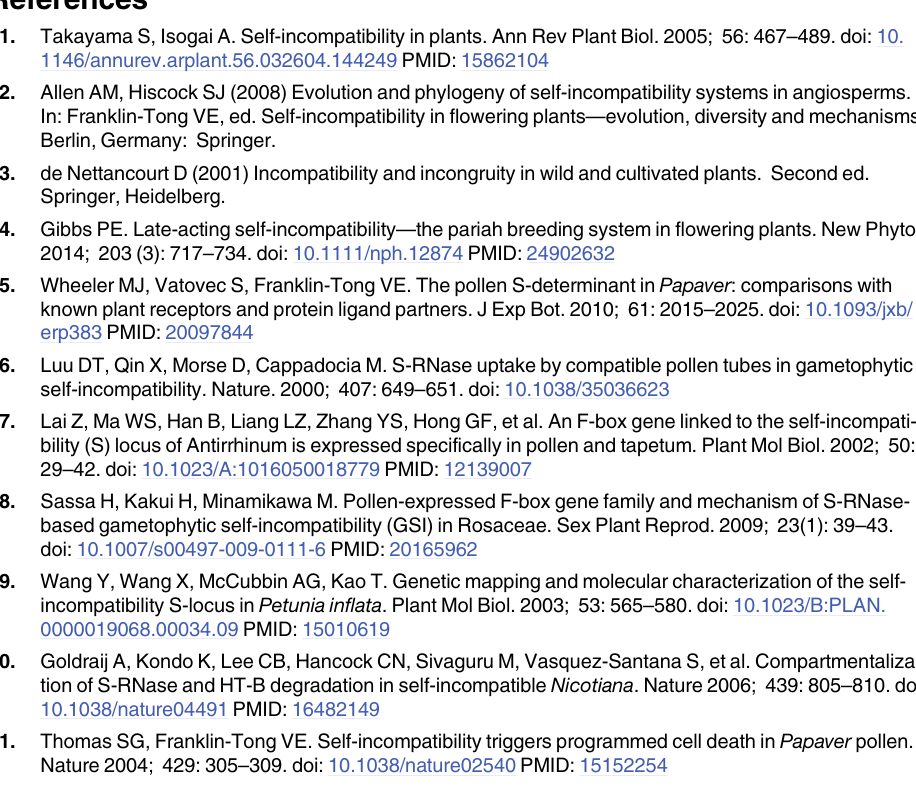
S5 Table. Unigenes assigned with KO number and EC number. S6 Table. The BRITE functional mapping categorized the unigenes into 252 KEGG path- ways. S7 Table. Seventy-six unigenes expressed specifically or preferentially in the selfed ovules were assigned with KOG annotation and classification. S8 Table. GO terms were assigned to the genes expressed specifically or preferentially in the selfed ovules of Xanthoceras sorbifolium